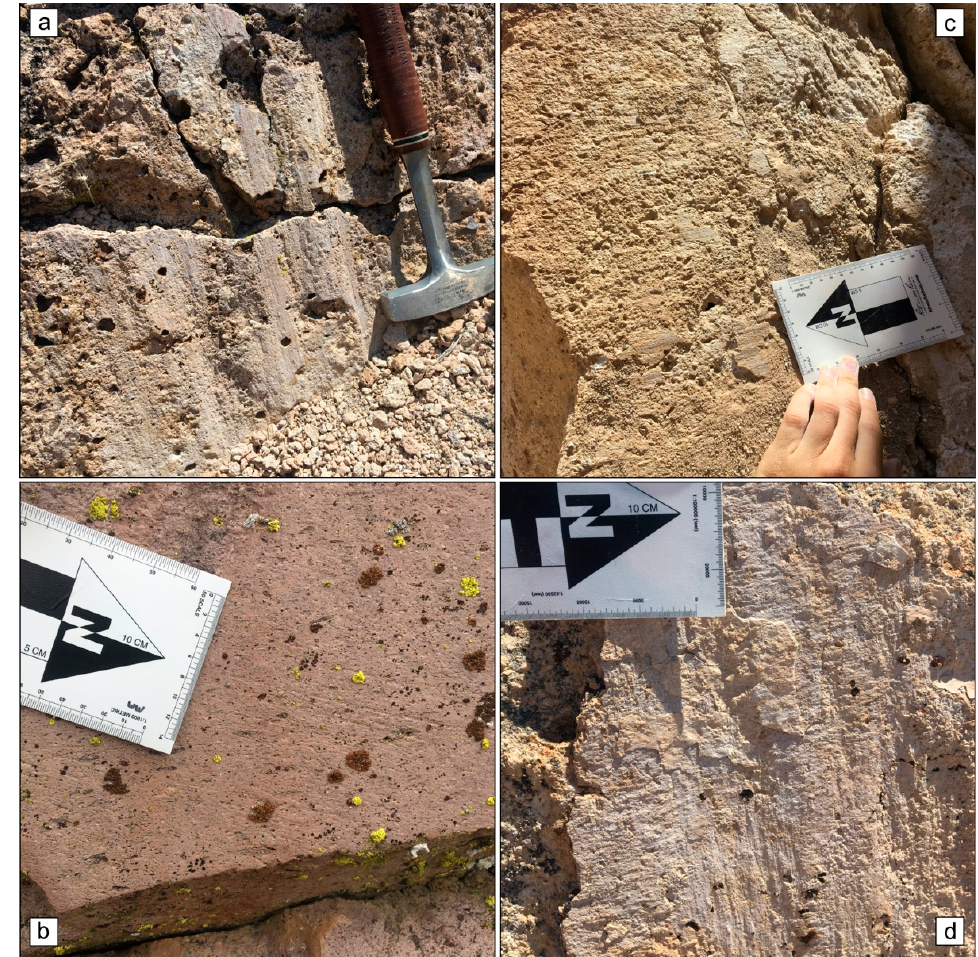
Figure 5. Fault surfaces and variable kinematics discovered on the Volcanic Tableland. All shown fault planes are steeply dipping. Please refer to the supplementary data (Figure S1) for a full set of images of observed slickenlines. ( a ) Dip-slip slickenlines. ( b ) Oblique-slip grooves, orientation indicated by scale-bar arrow. ( c ) Near-horizontal strike-slip slickenlines, orientation indicated by scale-bar arrow. ( d ) Older horizontal slickenlines (indicated by arrow) are overprinted by younger vertical slickenlines in laminar caliche.